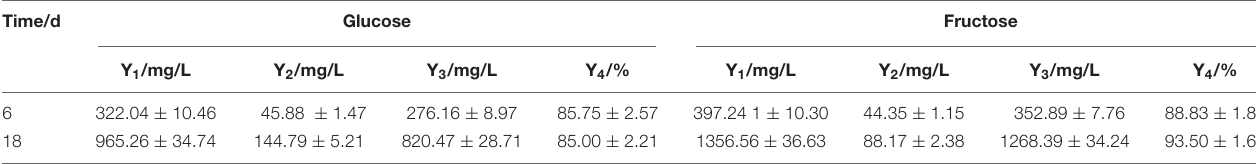
TABLE 1 | Intracellular and extracellular levels of PB 0 and intracellular PB 0 ratio with different carbon sources. Time/d Glucose